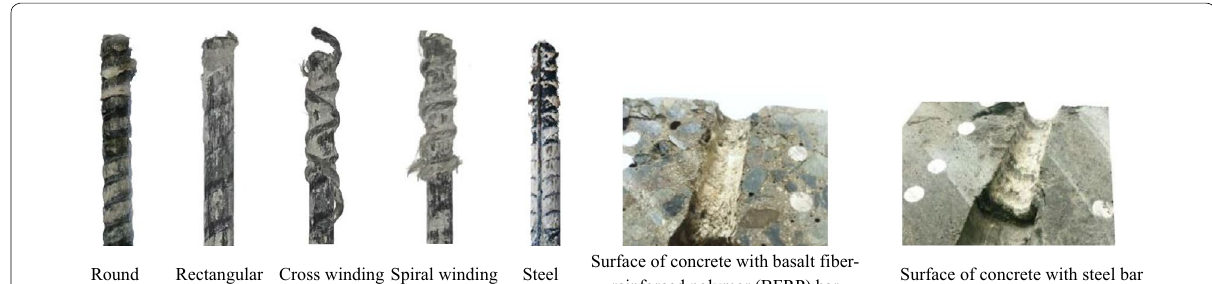
Fig. 4 Failure modes under mono-tensile